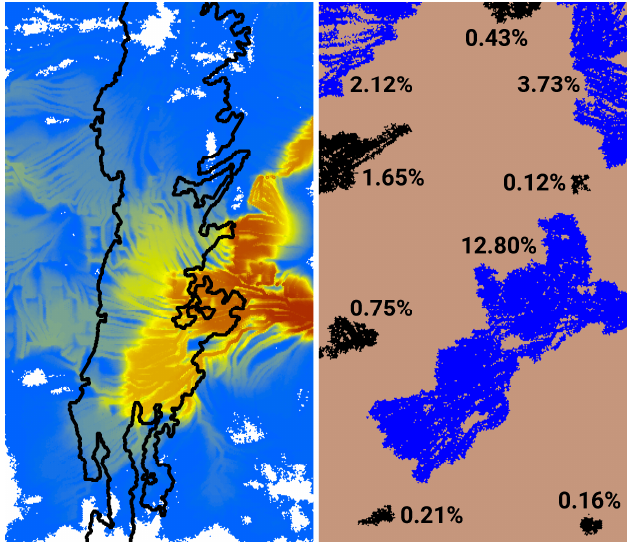
Figure 8. Mean burn frequency generated from 1000 fire simulations ( left ), and nine illustrative non-overlapping fires selected from this collection ( right ). Mean burn frequency is displayed using the color ramp of Figure 4, and the black outline indicates the extent of marten habitat. Burn sizes indi- cate the proportion of the landscape consumed by a single fire. The color assigned to individual fires (black vs. blue) has no significance.